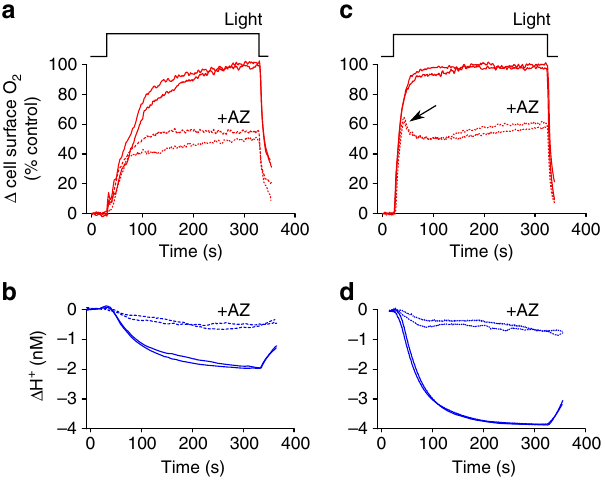
Fig. 5 The cell surface microenvironment under low DIC conditions. a Detailed view of the increase in cell surface [O 2 ] following illumination of an O. sinensis cell in ASW media containing 2 mM DIC at pH 8.0 with or without the addition of 100 µ M AZ. The O 2 traces are shown as % of the untreated control. b The decrease in cell surface [H + ] for cells shown in a . c Cell surface [O 2 ] around an O. sinensis cell in ASW media containing 0.5 mM DIC at pH 8.0 with or without the addition of 100 µ M AZ. In the presence of AZ at 0.5 mM DIC, the initial rise in [O 2 ] at the cell surface is very similar to the untreated control, but this rate cannot be sustained and falls to a lower level. d The decrease in cell surface [H + ] for cells shown in c . The depletion of [H + ] at the cell surface is much greater at 0.5 mM DIC than at 2 mM DIC. Representative traces are shown from two individual cells, n = 7 cells